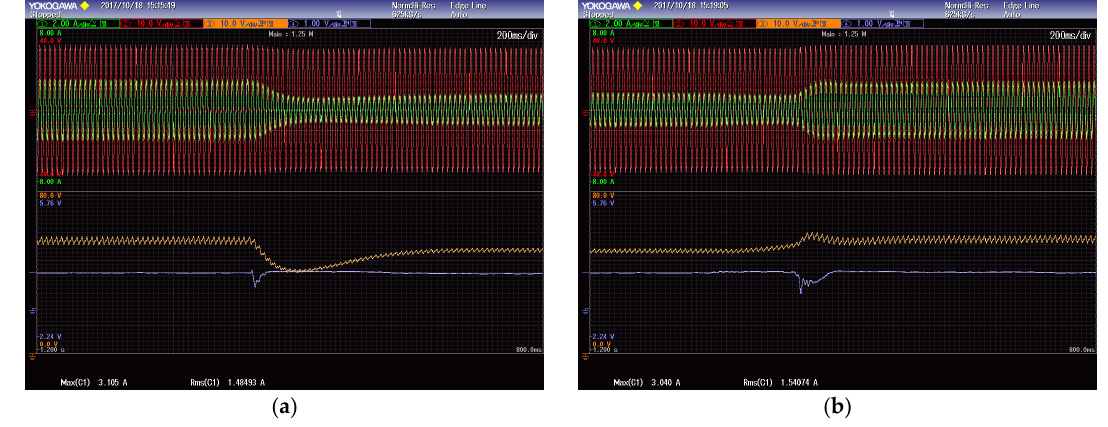
Figure 21. Decrease and increase sun irradiance transients (500 W/m 2 –200 W/m 2 ) using only the 50-Hz harmonic component